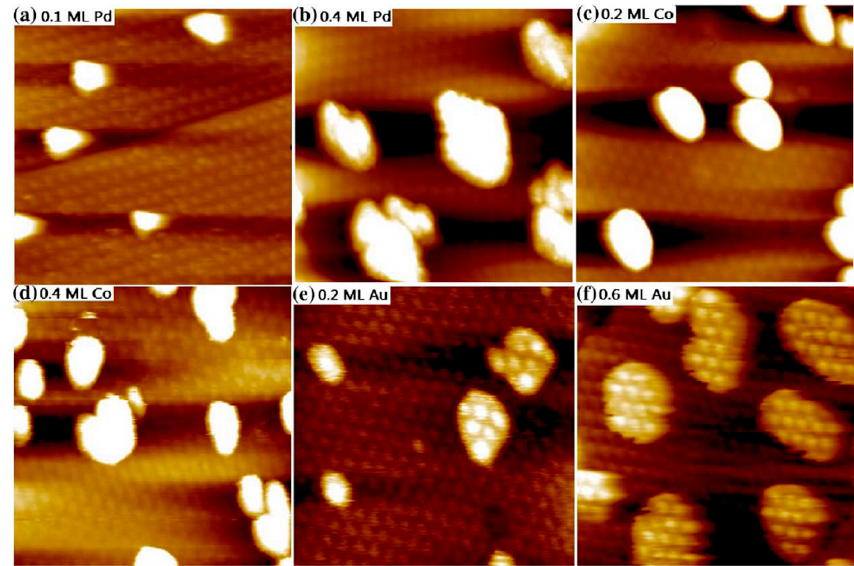
Figure 10. Scanning Tunneling Microscopy images (50 nm × 50 nm) of ( a ) 0.1 ML Pd; ( b ) 0.4 ML Pd; ( c ) 0.2 ML Co; ( d ) 0.4 ML Co; ( e ) 0.2 ML Au and ( f ) 0.6 ML Au deposited on graphene/Ru(0001) at room temperature. Reproduced from Reference [65] with permission from the Elsevier.